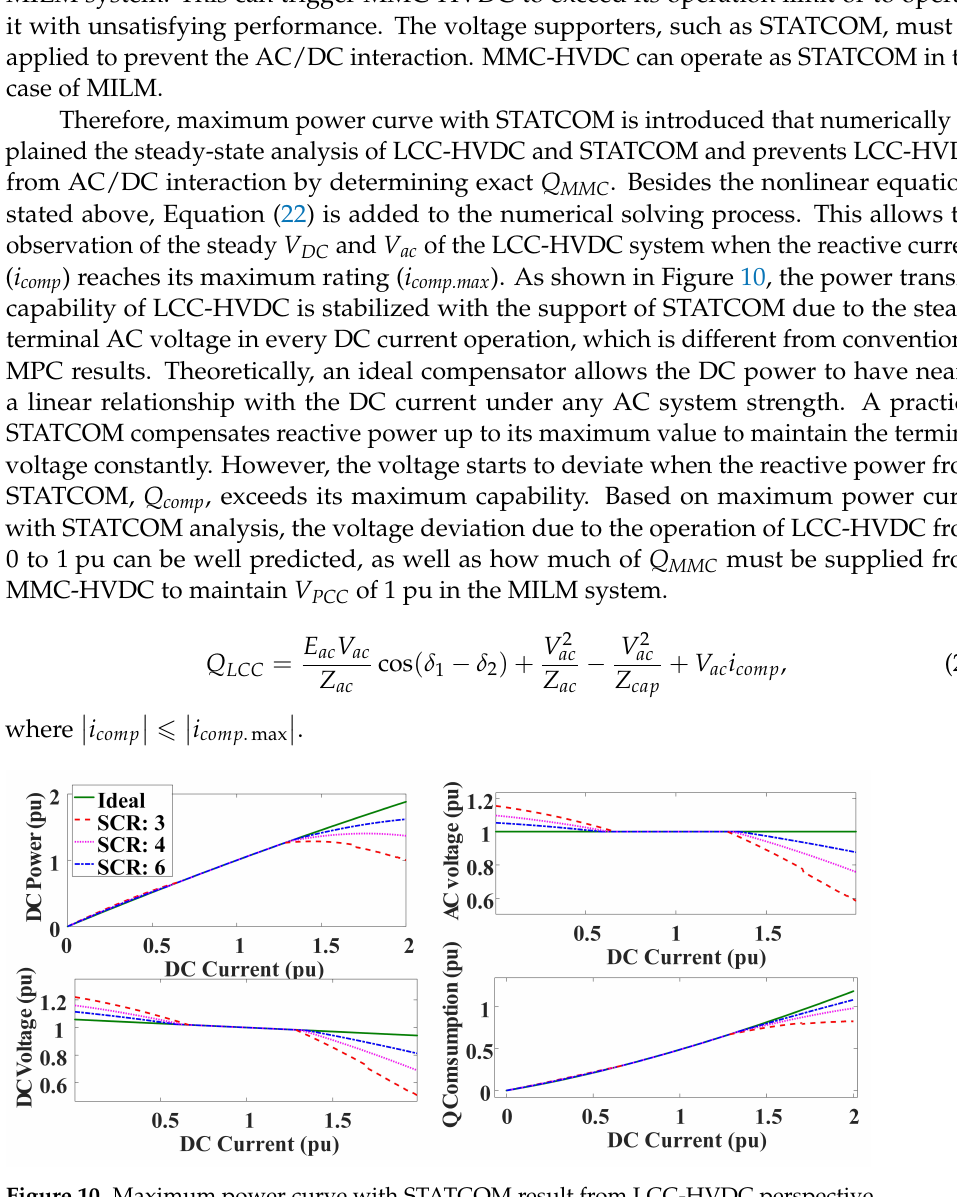
Figure 10. Maximum power curve with STATCOM result from LCC-HVDC